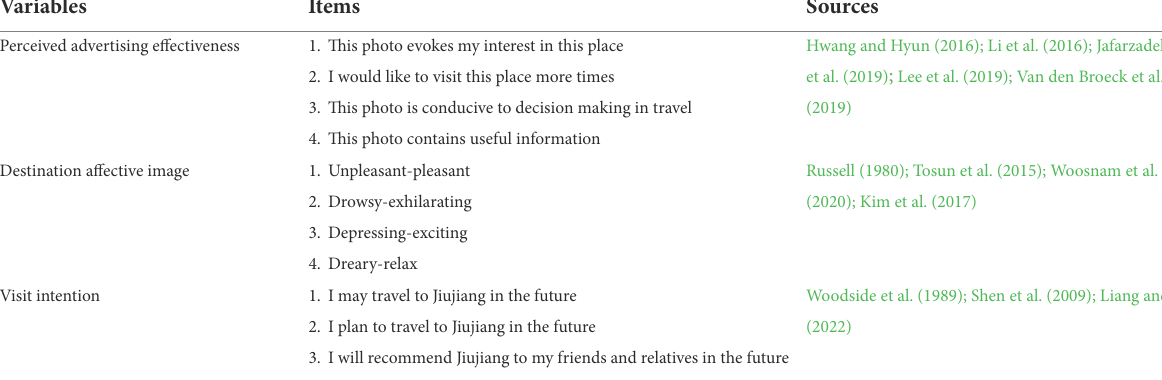
TABLE 1 Scales source.